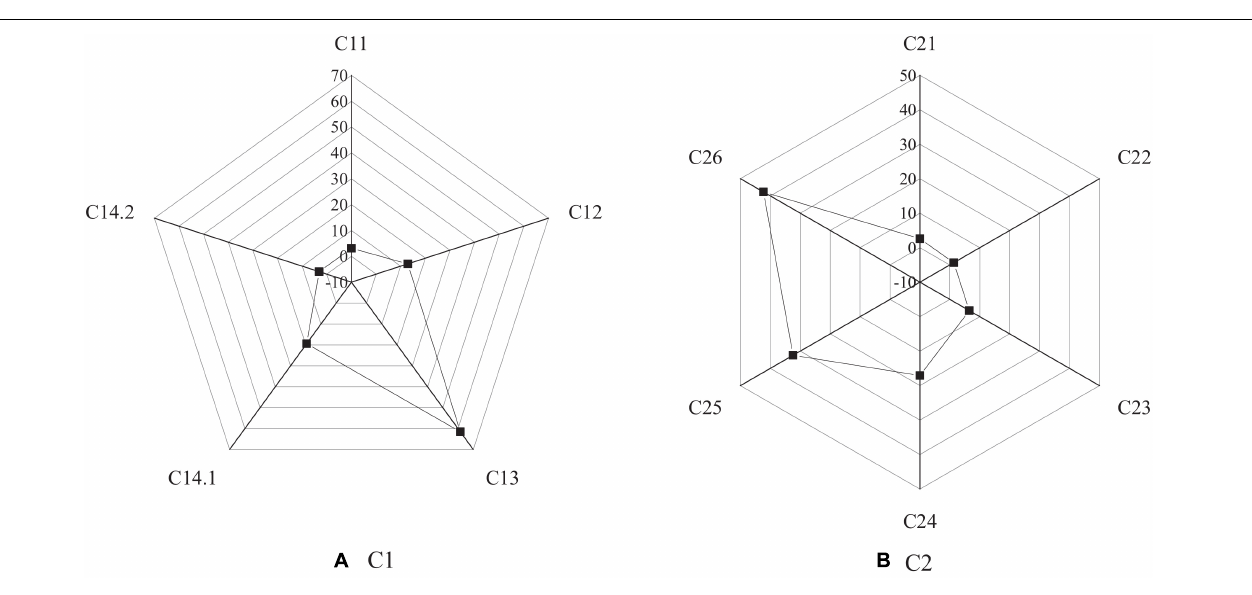
FIGURE 3 | Results of the reliability analysis of the questionnaire.